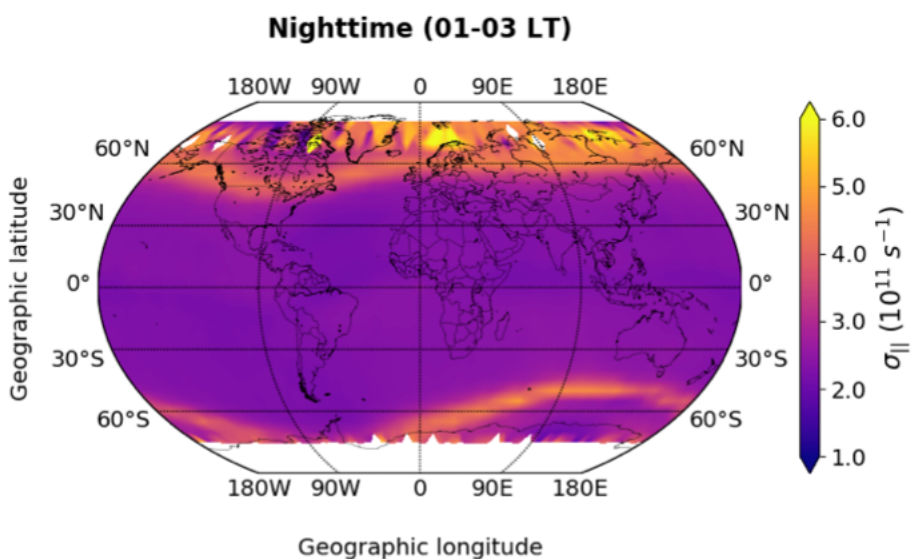
Figure 1. Maps in geodetic coordinates of σ || in the daytime ( top panel) and in the nighttime ( bottom panel) derived from CSES-01 data. The values within each bin are saturated between 1.0 × 10 11 s − 1 and 6.0 × 10 11 s − 1